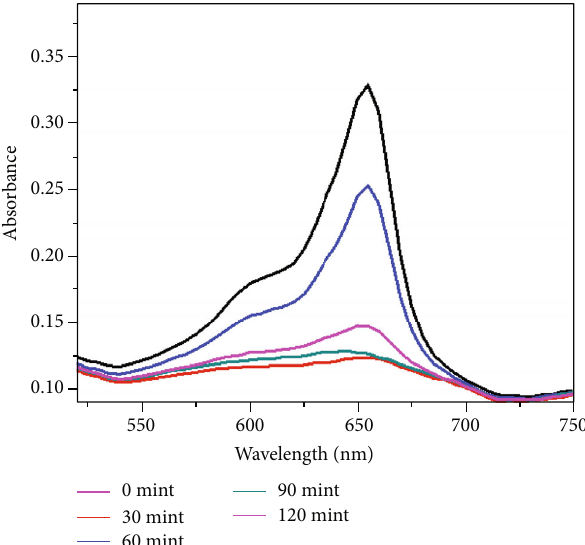
Figure 7: UV/visible spectrum shows the degradation studies of MLB